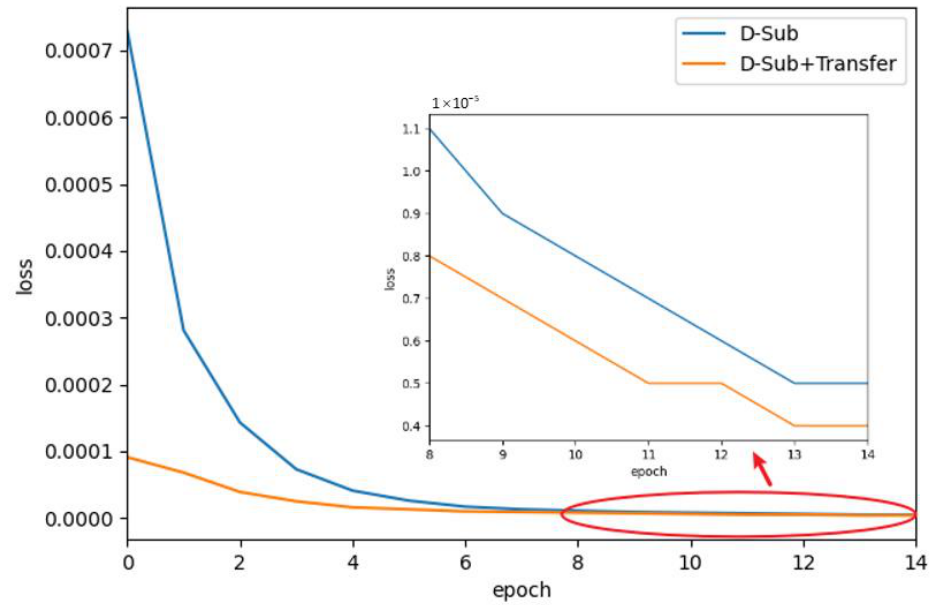
Figure 16. The learning curve on the real dataset.